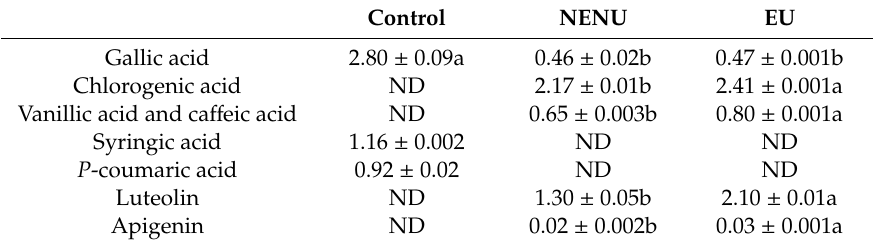
Table 7. Contents of identified phenolic compounds in extracts from Jizi439 BWB ( μ g/mg dry matter).